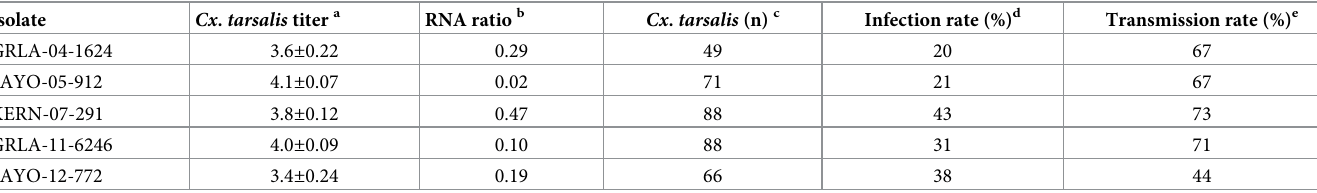
Table 2. Blood meal exposure of Culex tarsalis females and resulting infection rates.